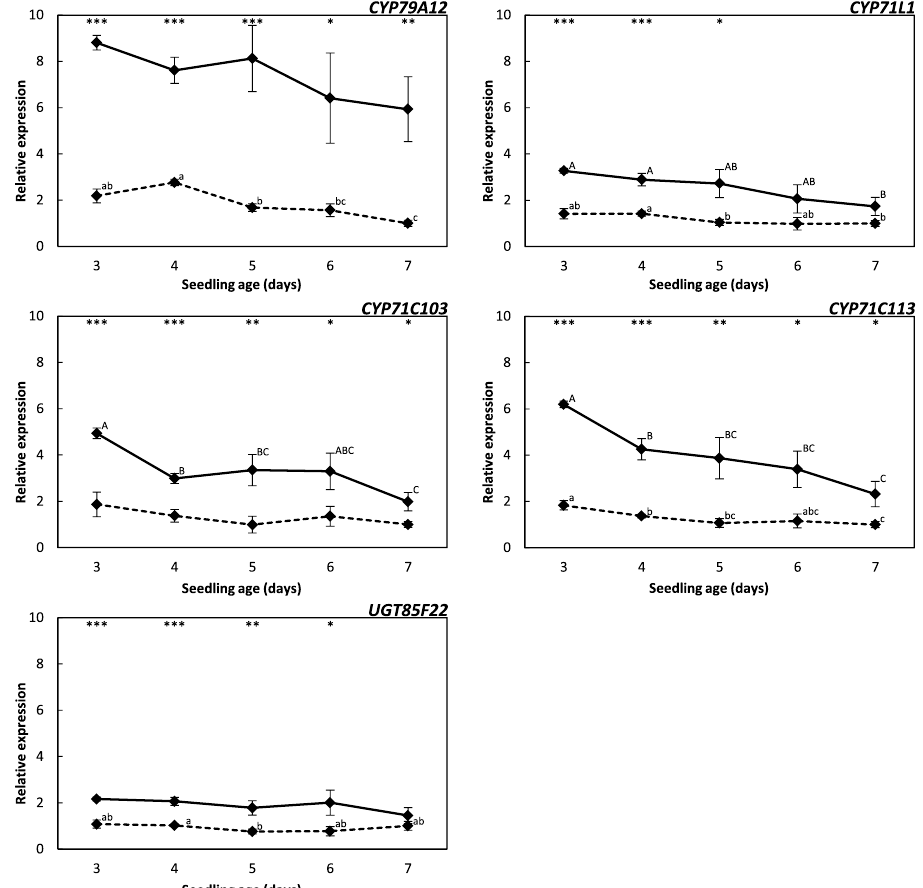
Figure 3. Relative expression of hydroxynitrile glucoside biosynthesis genes over time in shoot tissue of the cvs. Pallas (dashed lines) and Mentor (solid lines). The expression levels were normalized to three reference genes. Cultivar-specific relative expression levels were calculated by comparison to day seven as reference (data shown as means ± s.e.). Gene-specific expression levels and standard errors from cv. Mentor were corrected with a multiplication factor calculated by comparison of the expression levels between the cultivars at day seven. Asterisks indicate significantly different expression levels between the cvs. Pallas and Mentor ( *** p < 0.001, ** p < 0.01, * p < 0.05). Significantly different groups (p at least < 0.05) within the cultivars are indicated by small letters (Pallas) and capital letters